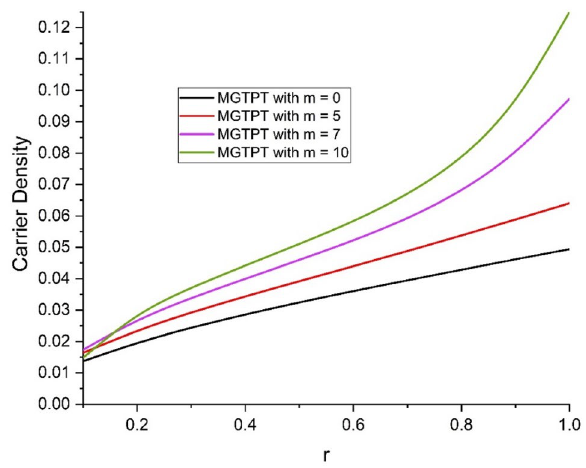
Fig. 6 The change in hoop stress with Hall Effect under